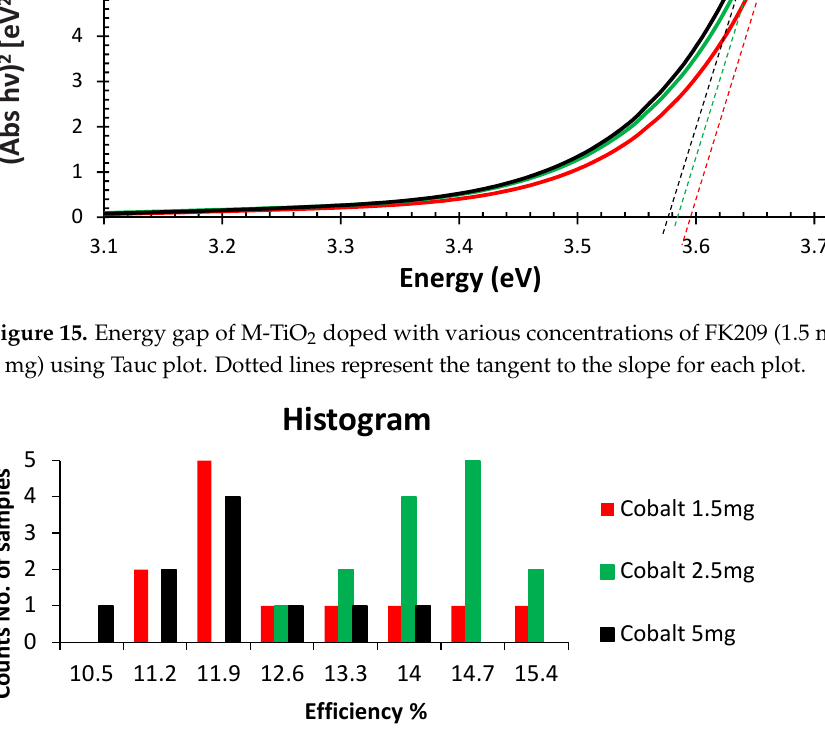
Figure 16. Statistical histogram of the PCE measured over 30 fabricated solar cells. The ETL was fabricated using C-TiO 2 prepared using DC-sputtering and M-TiO 2 doped with various concentrations of FK209.